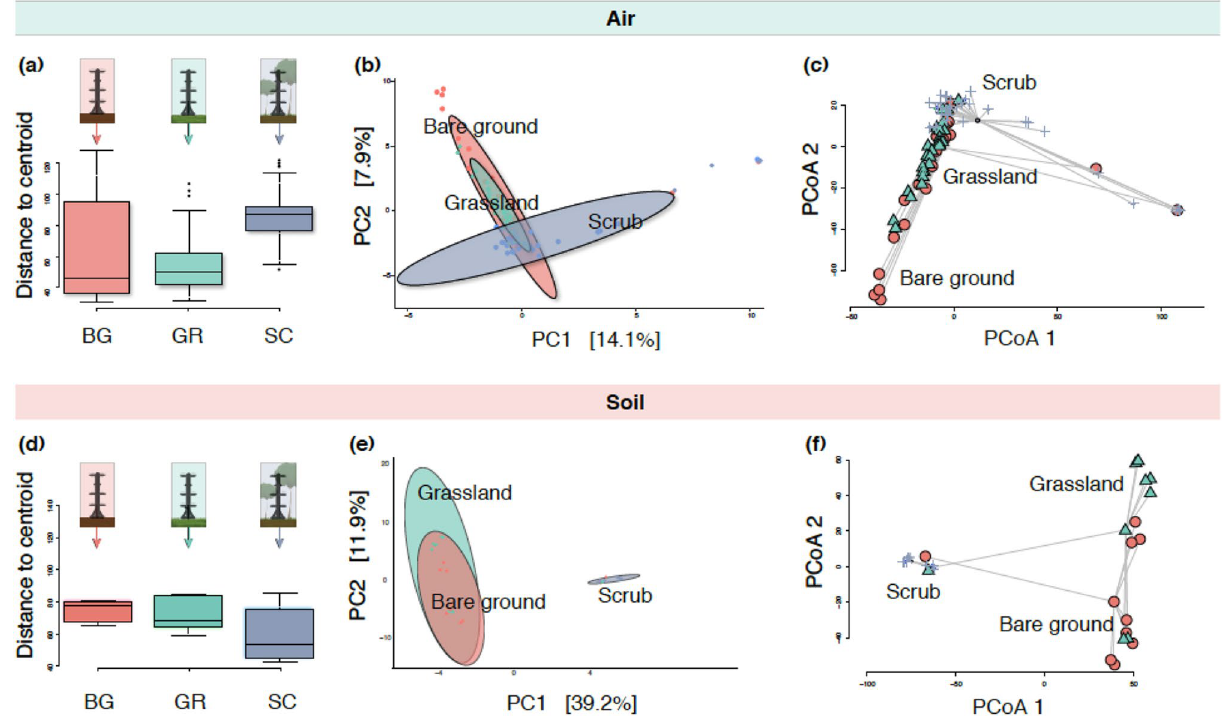
Figure 2. Upper panels show air samples only, whereby ( a ) is a boxplot of dispersion (spread); ( b ) ordination of bacterial communities for all habitats ( BG bare ground, GR grassland, SC scrub), ellipses represent Euclidian distance from the centre—with the radius equal to the confidence level (0.95); and ( c ) ordination of dispersion by Aitchison Distance. Lower panels show soil samples only, whereby ( d ) is a boxplot of dispersion; ( e ) ordination of bacterial communities for all habitats, ellipses represent Euclidian distance from the centre; and ( f ) shows an ordination of dispersion by Aitchison